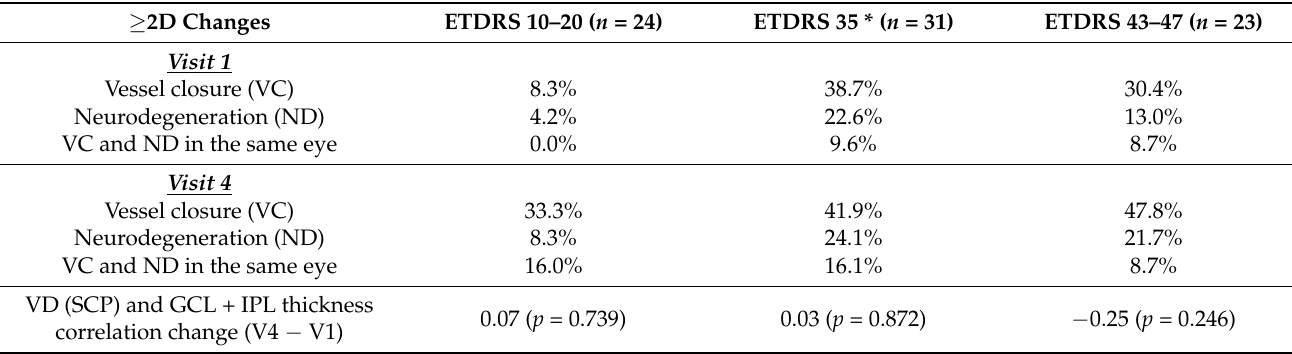
Table 2. Percentage and correlation of changes of vessel closure and neurodegenerative changes ≥ 2 SD at baseline and last